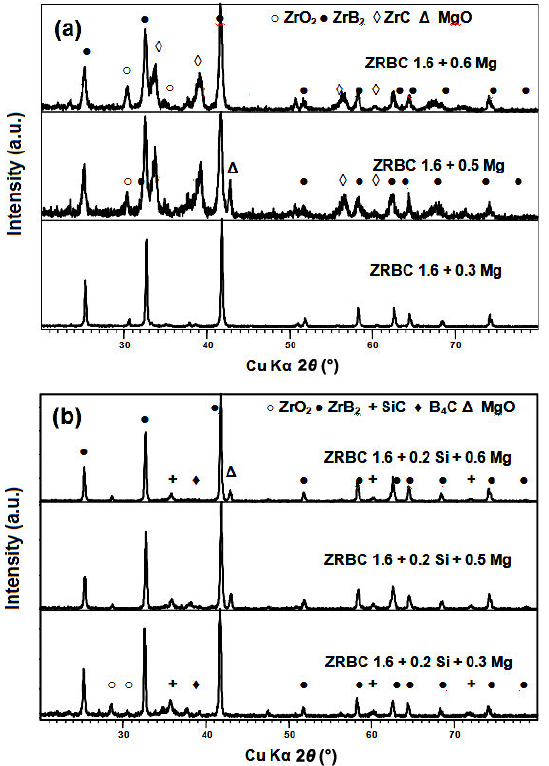
Fig. 8 Effect of Mg content on (a) ZRBC1.6 and (b) ZRBC1.6+Si. XRD patterns are after FT assisted reaction and leaching with HCl